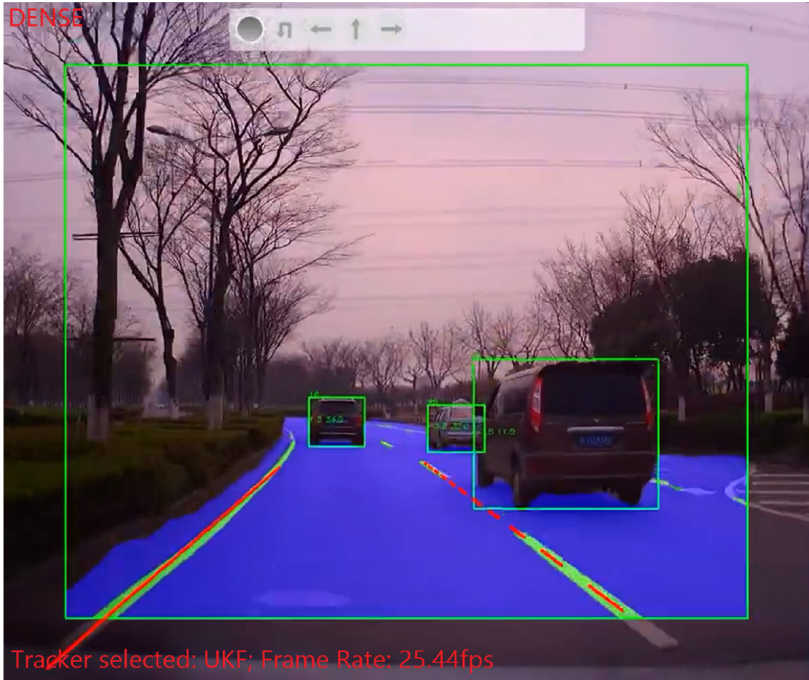
Figure 19. Image taken at t = 13.03 s. Traffic state: Dense. Tracker—UKF.